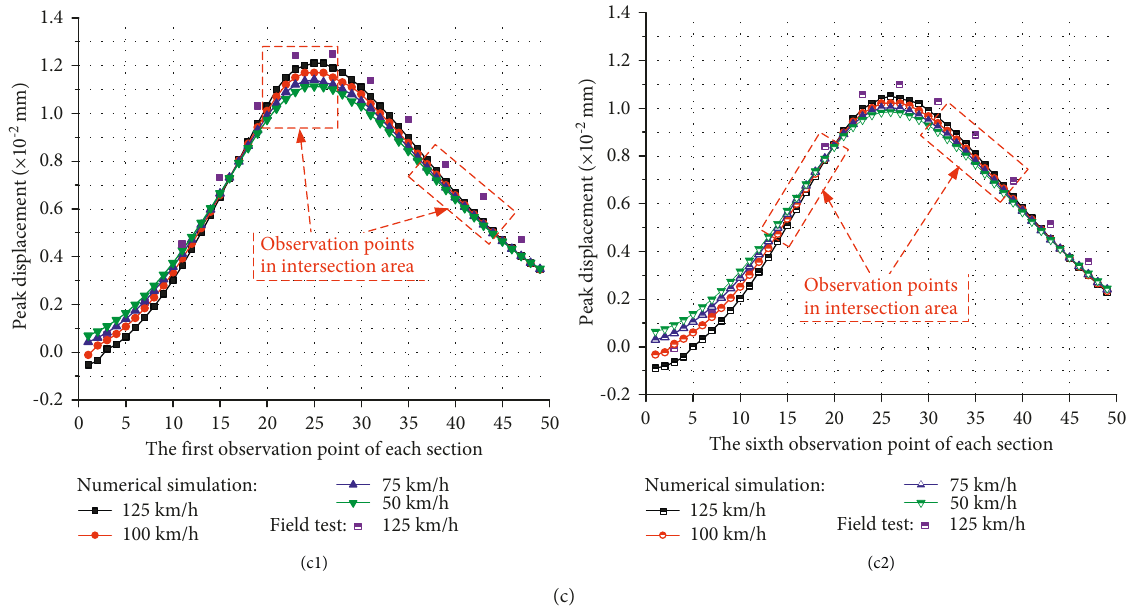
Figure 11: Peak displacement of observation points on existing tunnel: (a) shield excavation reaches the 15 th ring on the left; (b) shield excavation reaches the 30 th ring on the left; (c) shield excavation reaches the 52 th ring on the